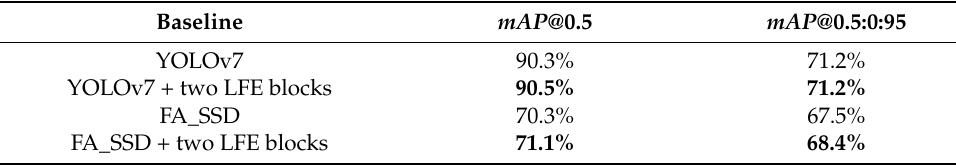
Table 4. Effect of the LFE module in other advanced